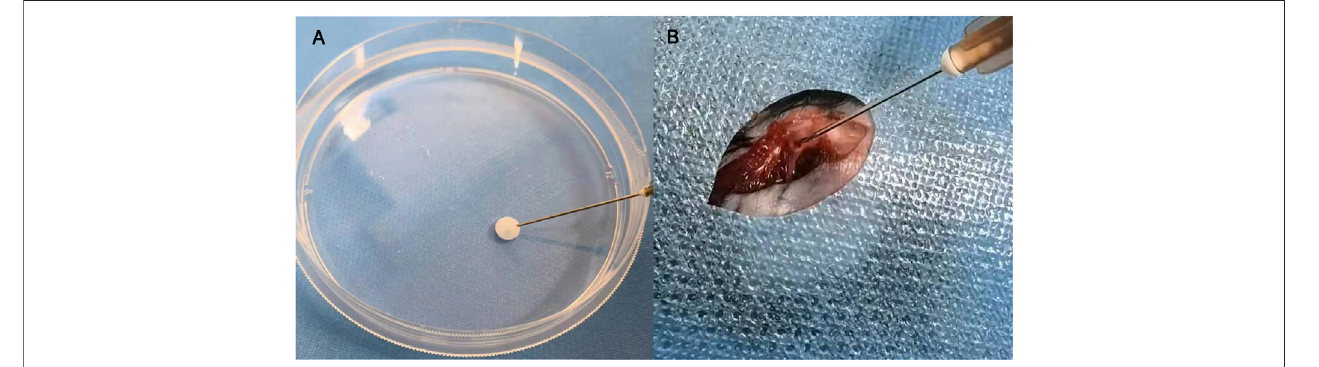
FIGURE 4 | Bone-forming units can be delivered by fi brin glue (A) ; the injection process of the bone-forming units in vivo (B) .